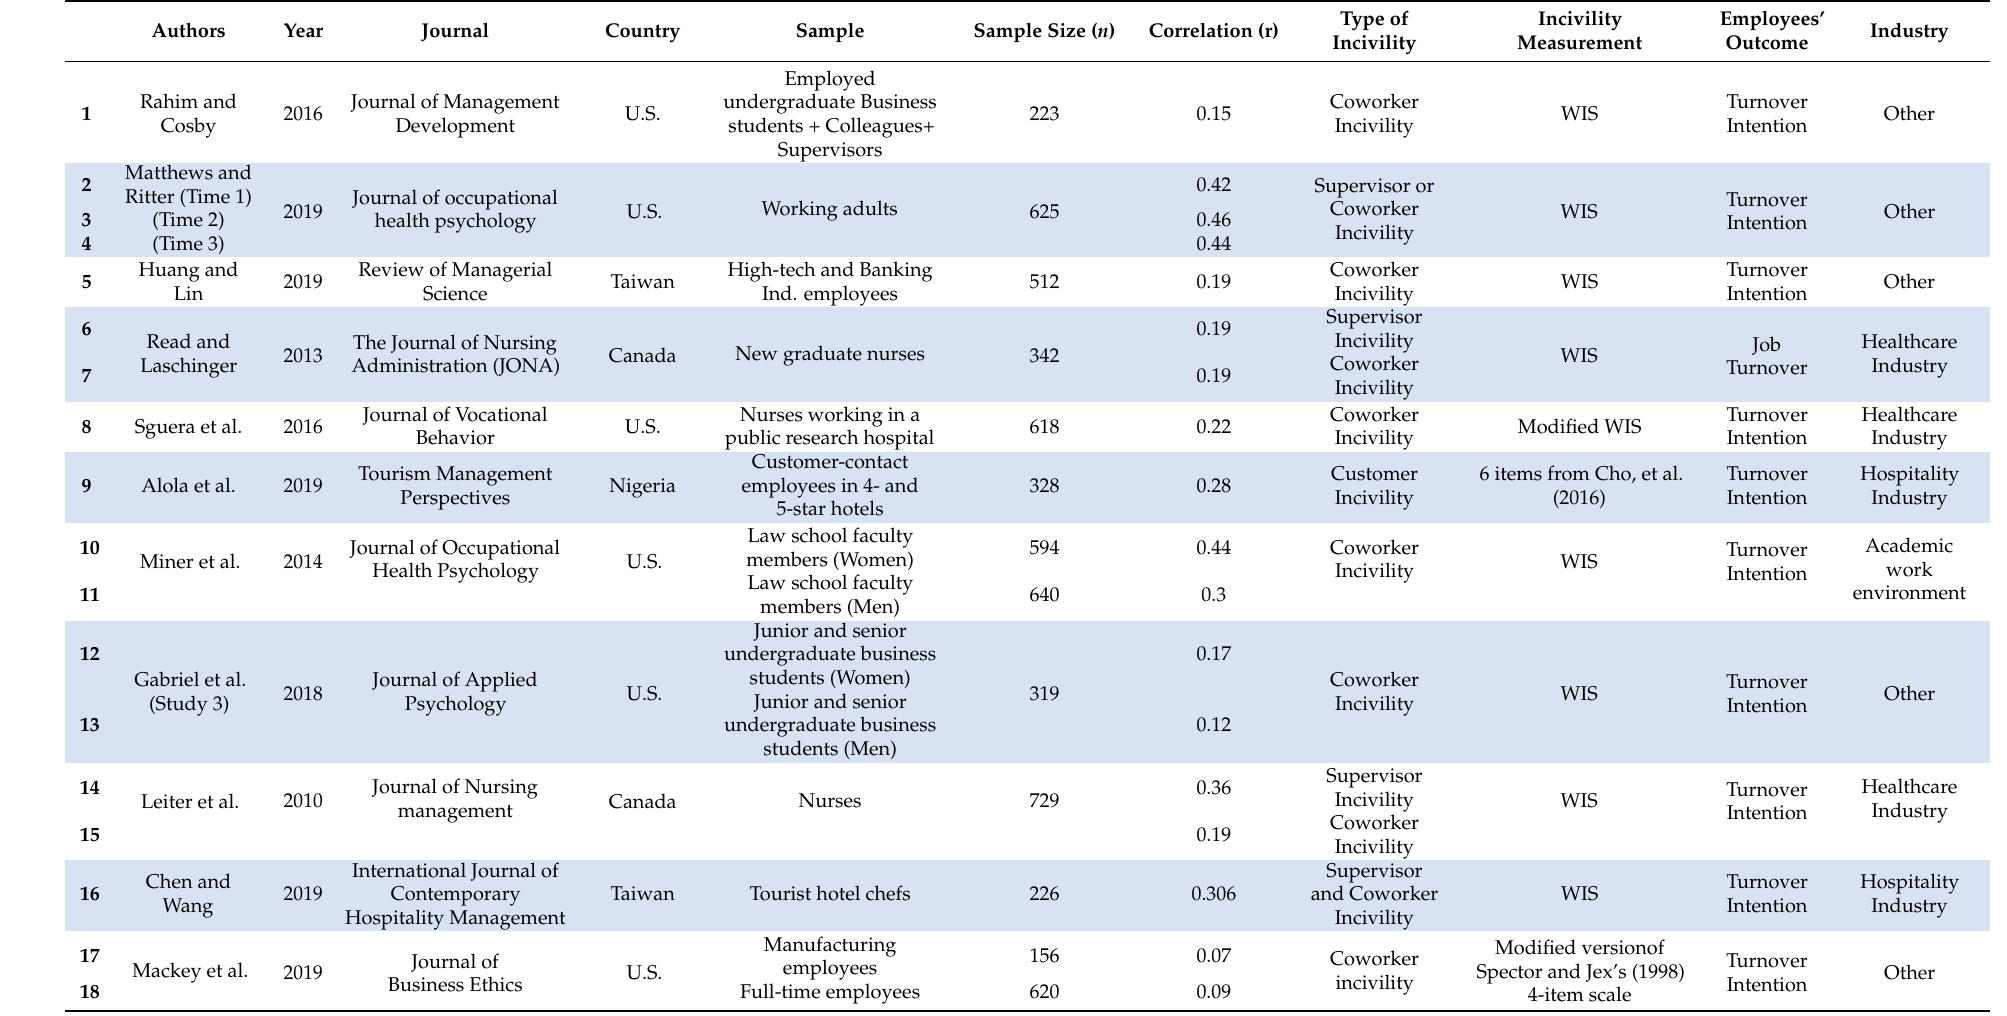
Table 2. Overview of studies